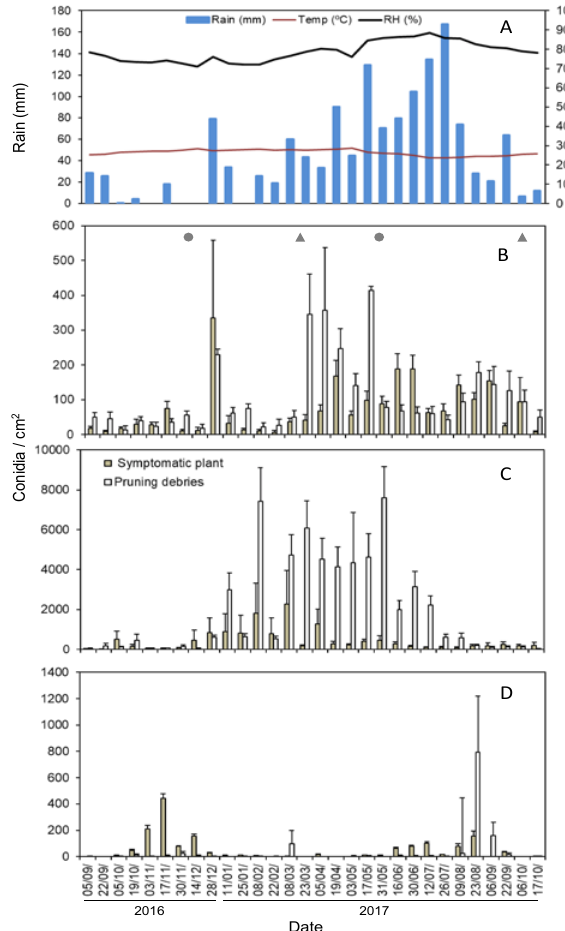
Figure 3. Numbers of conidia of Diplodia (B), Lasiodiplodia (C), or Neofusicoccum (D) sampled per cm 2 of microscope slide spore trap surface, from symptomatic plants or prun- ing debris, found between 22 August 2016 to 17 October 2017 in four vineyards in St Vicente Ferrer (Brazil); in A, the weather data are also presented. Spore traps were replaced every 2 weeks, commencing from 5 September 2016. Bars are averages for the four vineyards, and whiskers represent the standard errors. In B, grey triangles show the full flow- ering stage of plants (stage 65; Lorenz et al. , 2005) and grey circles show the berries ripe stage (stage 89).